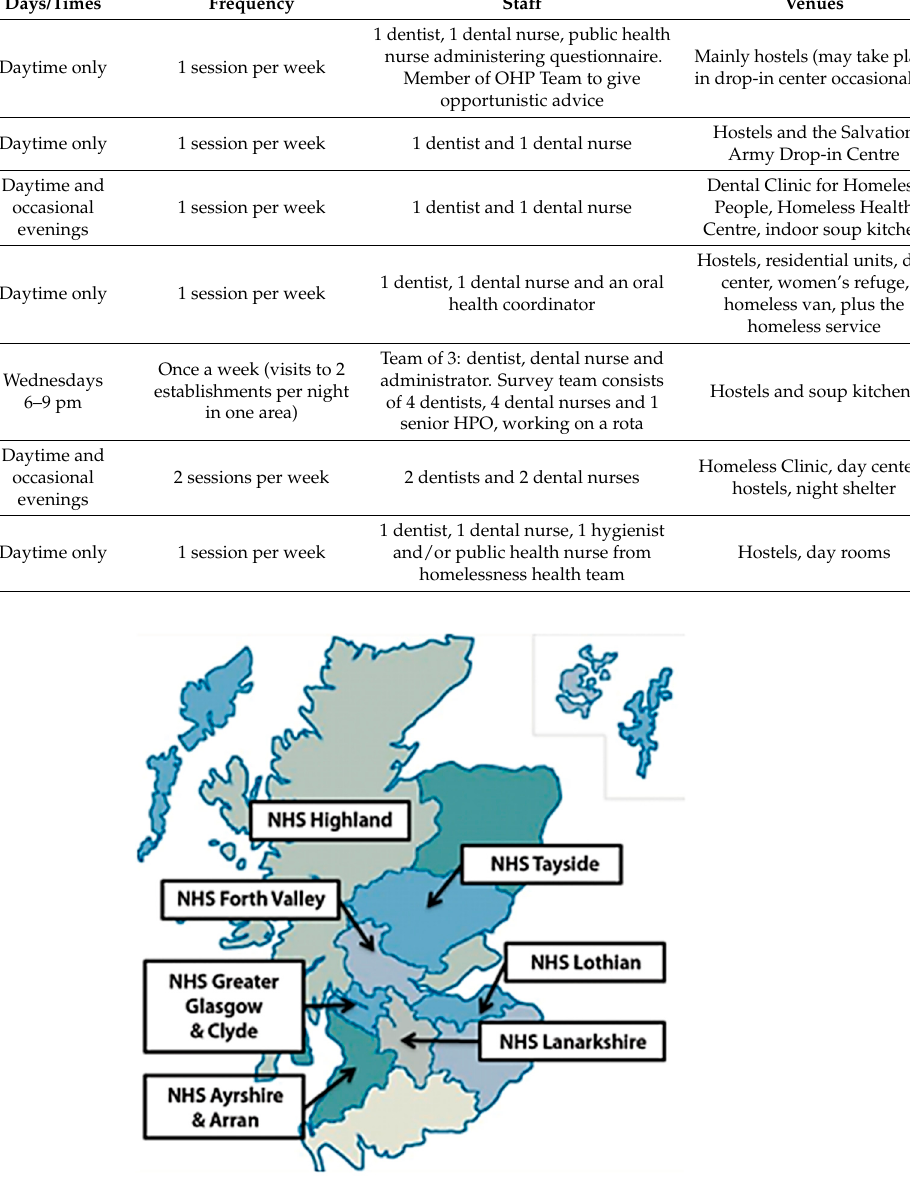
Figure 1. NHS Boards that participated in the Smile4life needs assessment (image reproduced from the Smile4life Report [12].